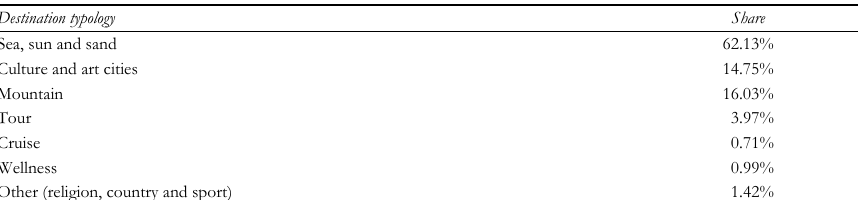
Holiday preferences in world